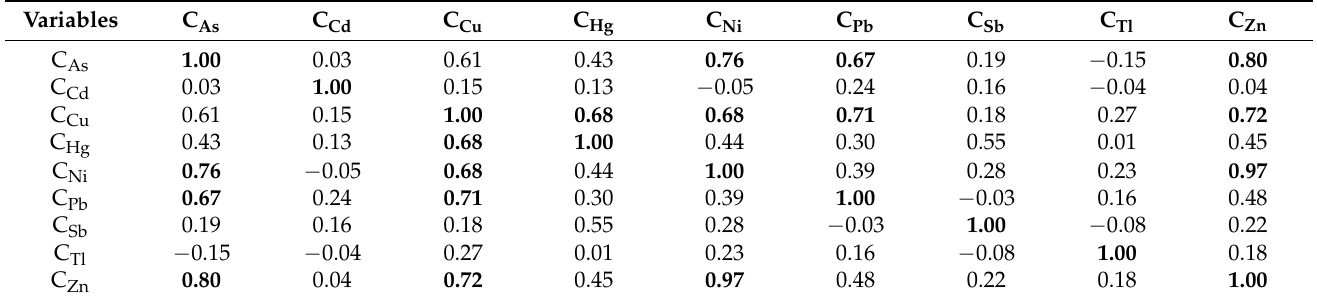
Table 4. Pearson correlation matrix among the considered variables. Values in bold are different from 0 at the significance level α =